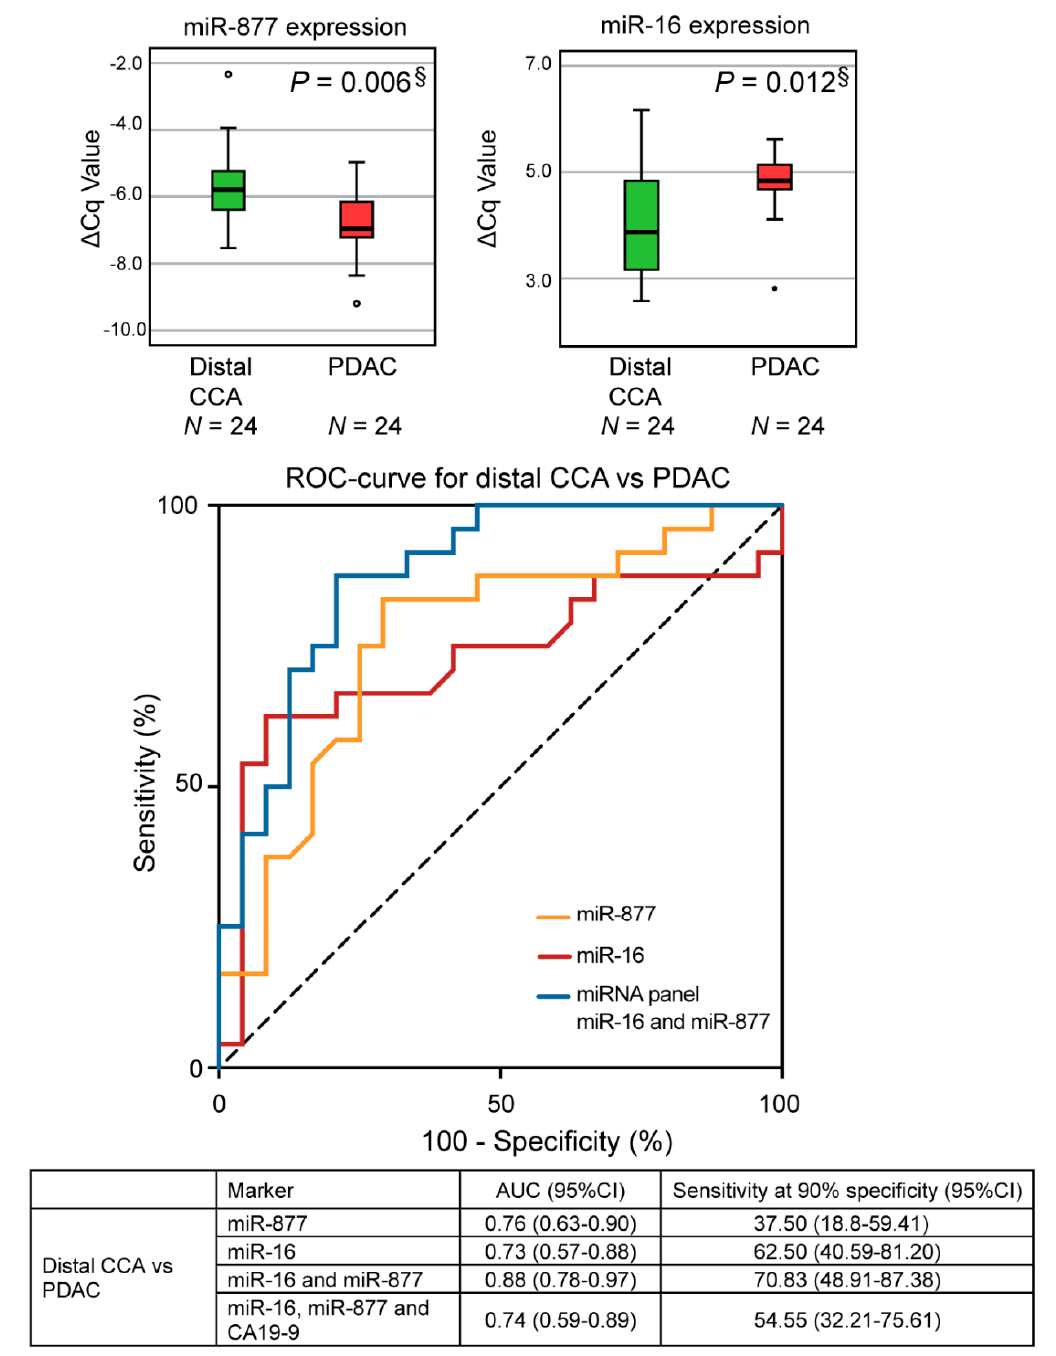
Figure 4. Performance of miRNA-based diagnostics to distinguish distal CCA and PDAC. Expression profiles of miR-877 and miR-16 were significantly different between distal CCA and PDAC ( P = 0.006 and P = 0.012). This two-miRNA panel could accurately distinguish patients with distal CCA from PDAC, with an AUC of 0.88. Box plots are displayed for the average Δ Cq values, with the horizontal lines representing the mean ± SD. Δ Cq = normalized Cq value, distal CCA = distal cholangiocarcinoma, miRNA = microRNA §Bonferroni-adjusted P -values are shown.